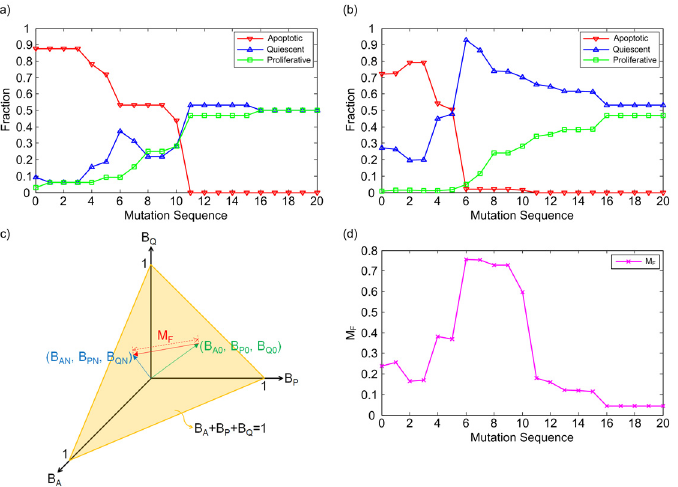
Fig 2. Flickering state transition during colorectal tumorigenesis in the conditions of N I = 0.03. Colorectal tumorigenesis is driven by the sequential accumulation of 20 gene mutations (the sequence of No. 73 in the S1 Table). Zero on the x-axis means no mutation. (a) and (b) the fraction of the initial states converging into the apoptotic, proliferative or quiescent attractors for 320,000 initial states at every gene mutation with N I = 0 and 0.03, respectively. (c) A graphical representation of M F (Eq (1)) to check the flickering state transition. B A , B P , and B Q represent the fractions of the basin sizes for the apoptotic, proliferative, and quiescent attractors, respectively. B A0 , B P0 , and B Q0 express the fractions of the basin sizes for the apoptotic, proliferative, and quiescent attractors in the absence of noise, respectively, and B AN , B PN , and B QN are the fraction of the basin sizes for the apoptotic, proliferative, and quiescent attractors in the presence of noise, respectively. (d) M F at every mutation occurrence for N I = 0.03, as a result of Fig 2(a) and